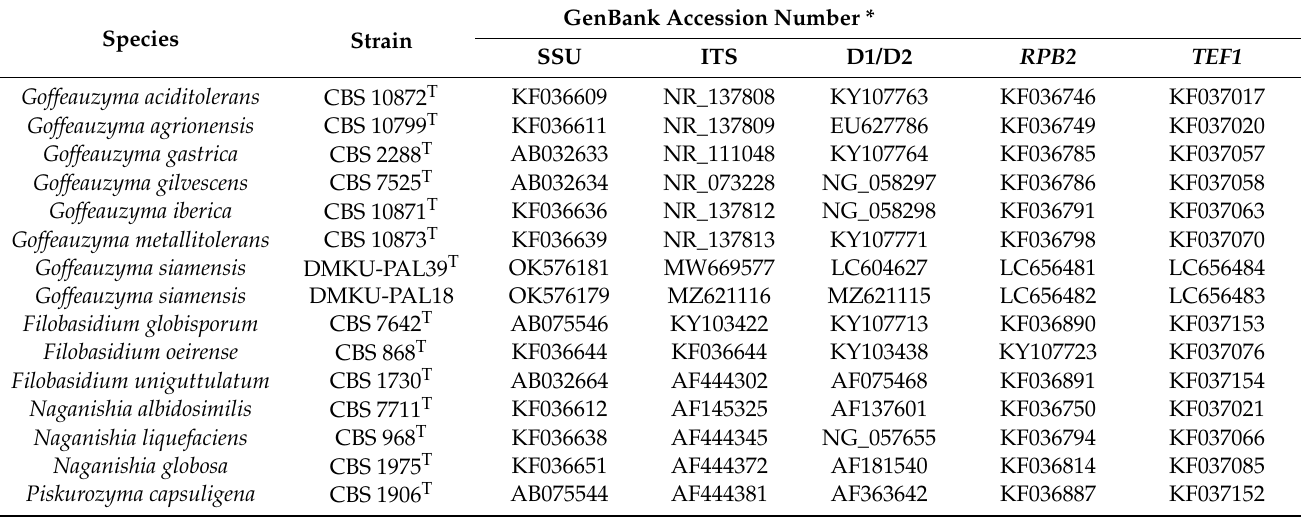
Table 2. Sequences of the representative species in the Filobasidiaceae (Basidiomycota) used in the phylogenetic